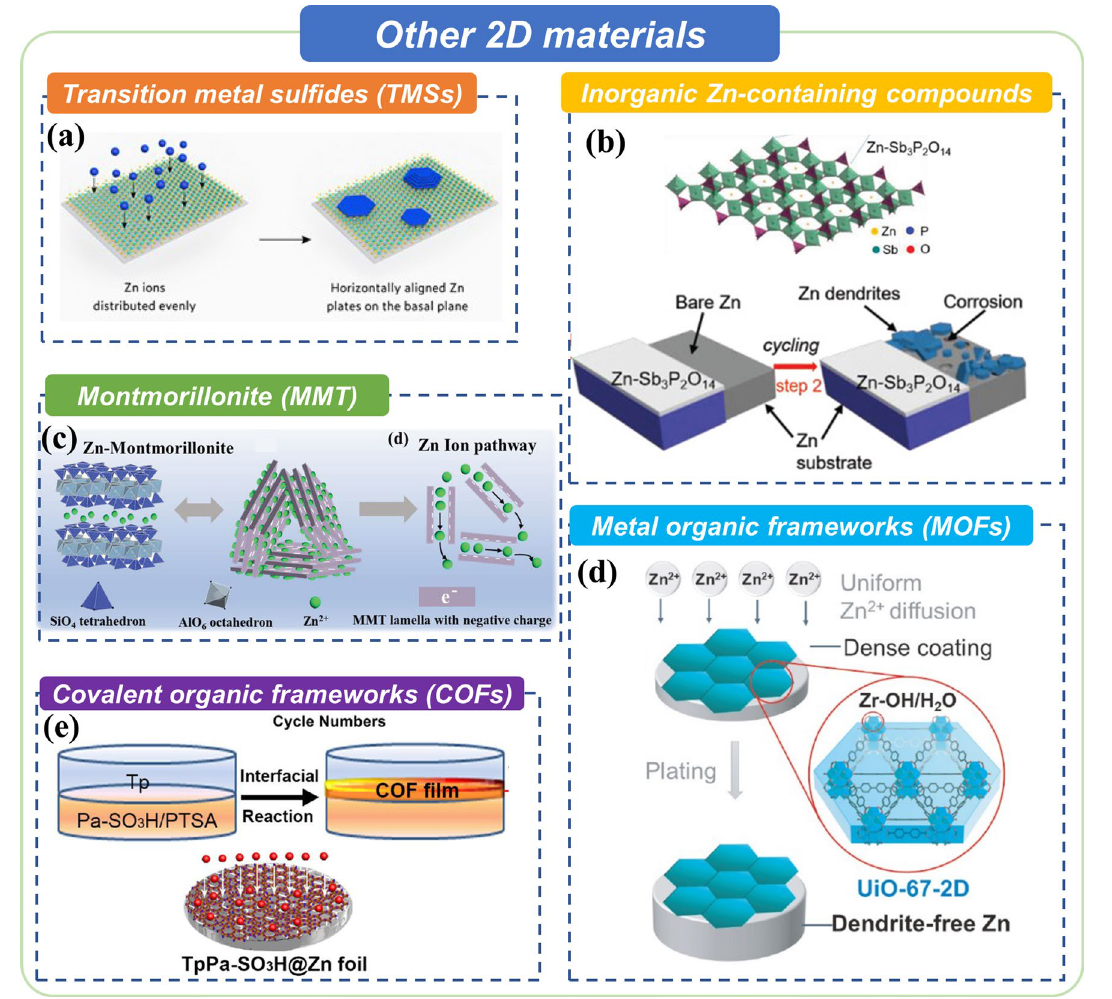
Fig. 7 Summary of other 2D materials for advanced Zn anode. a Transition metal sulfides (TMSs). Copyright 2022, Wiley. b Inorganic Zn-con- taining compounds. Copyright 2021, Wiley. c Montmorillonite (MMT). Copyright 2021, Wiley. d Metal organic frameworks (MOFs). Copyright 2022, springer. e Covalent organic frameworks (COFs). Copyright 2022,